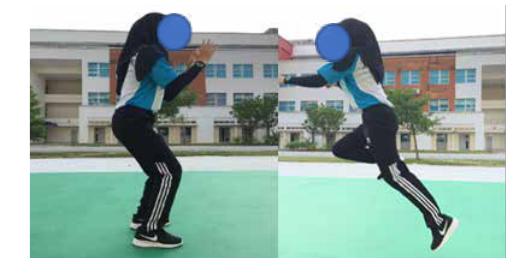
Figure 1. Balance training variations to